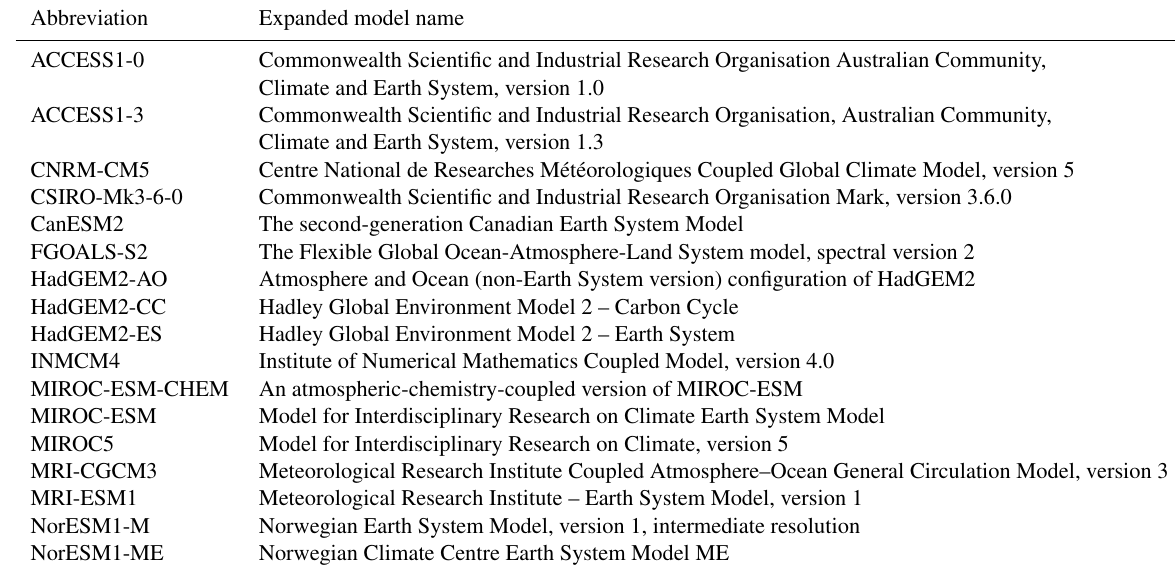
Table 1. Abbreviation and name of 17 CMIP5 models used in this